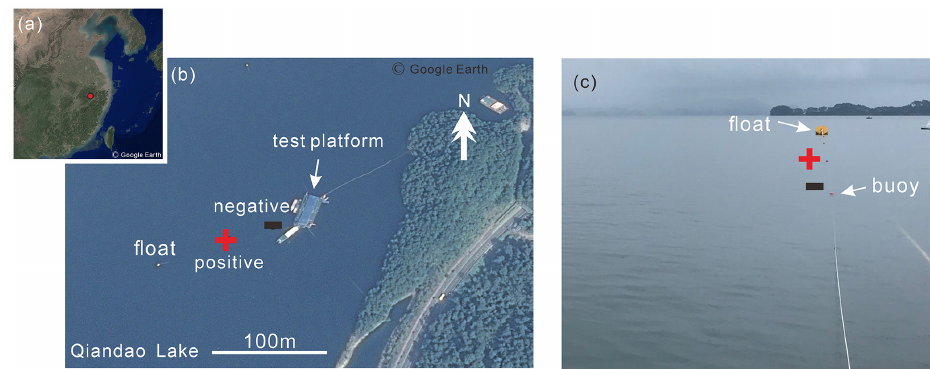
Figure 2. Layout of the artificial SP source. (a) Location of Qiandao Lake (© Google Earth, 2019). (b) Position of the artificial source in the water (plan view) (© Google Earth, 2019). (c) Zoomed in location of the artificial source. Red plus and black minus signs denote the positive and negative poles of the DC power, respectively.